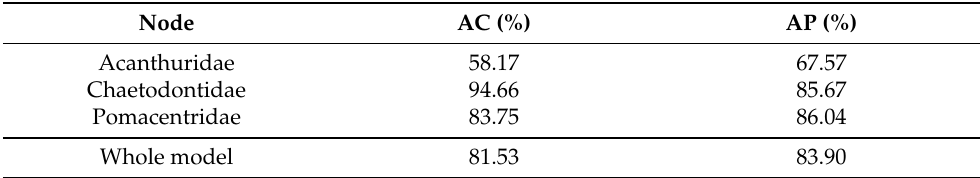
Table 6. Performance of leaf nodes (species) in the hierarchical model for the LCF-15 dataset. Leaf nodes contain an additional class called